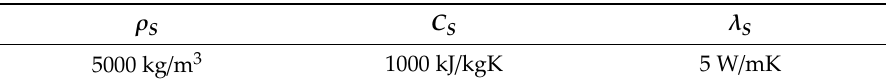
Table 2. Solid material